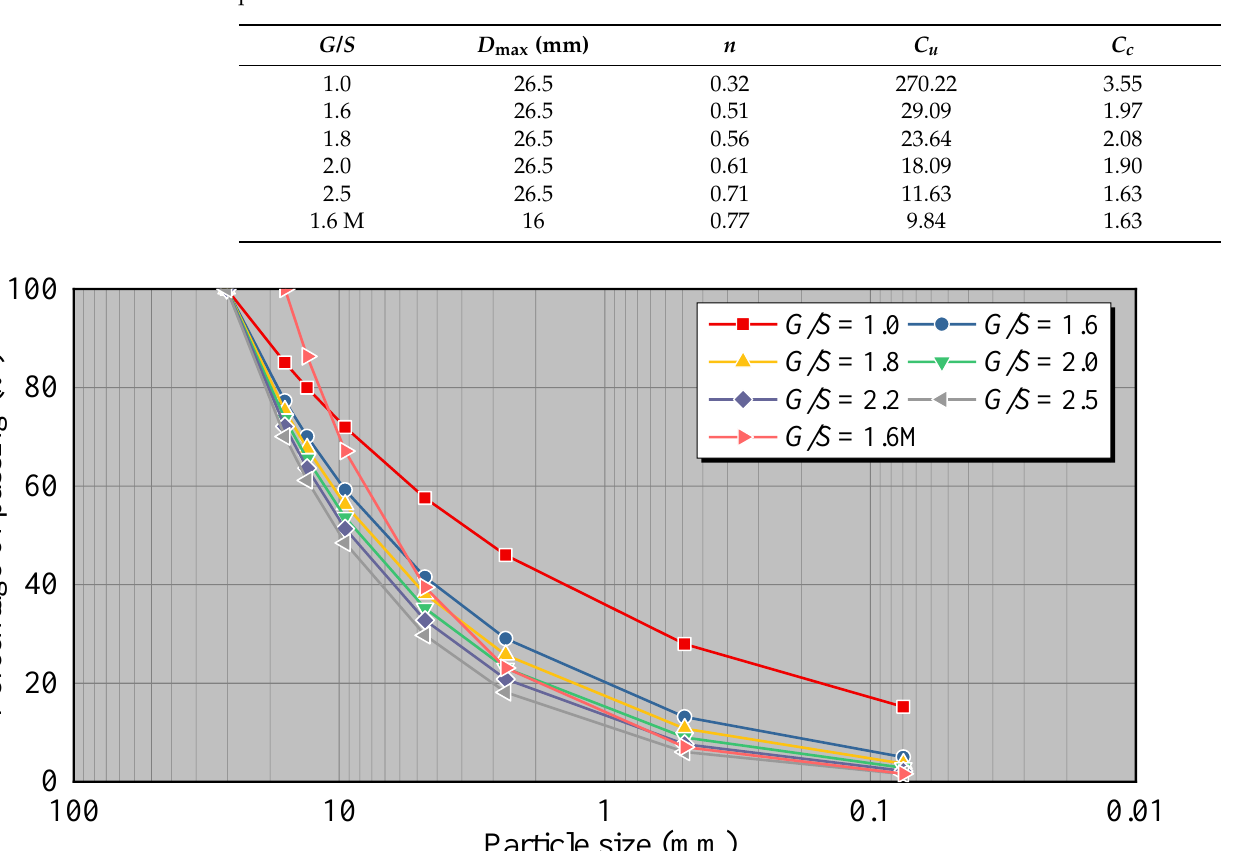
Table 1. Gradation design scheme and corresponding gradation parameters for Laboratory Com- paction Tests.